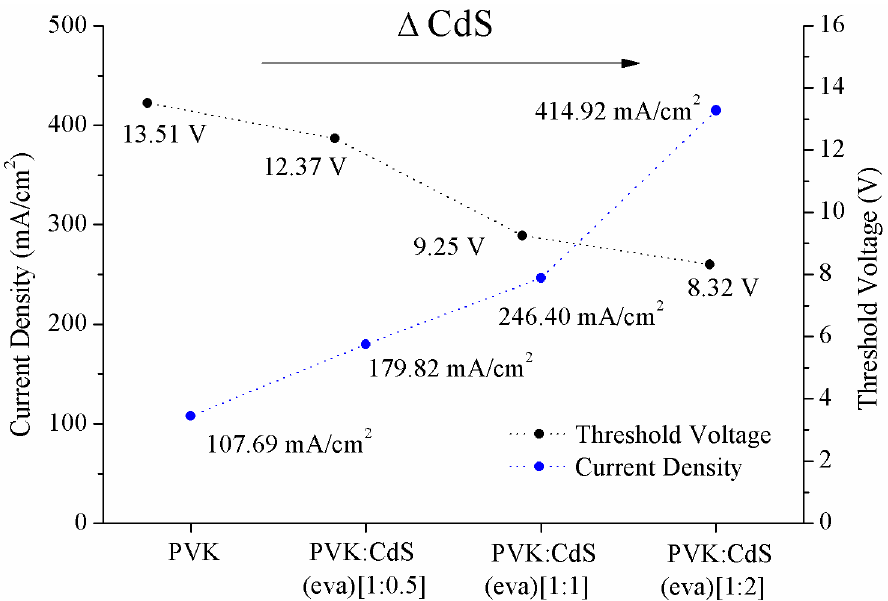
Figure 11. ( A ) J–V curves of the LEDs and ( B ) AFM image (area of 10 µm × 10 µm) corresponding to the hybrid LED with PVK:CdS(eva) [1:2] active layer. The color scale on the right indicates surface roughness.